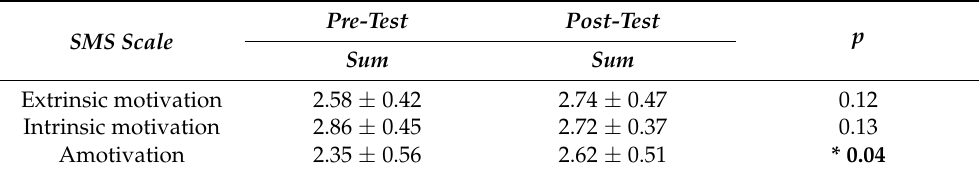
Table 7. The results of the SMS questionnaire in Test group 2. SMS